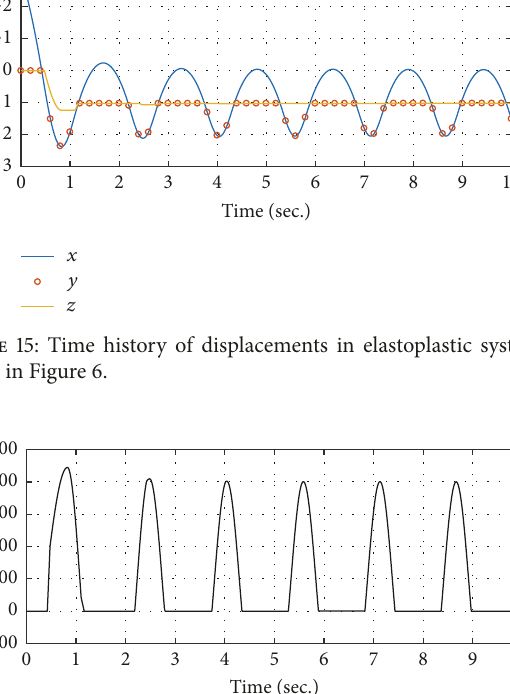
Figure 16: Time history of reaction 𝑅 in elastoplastic system shown in Figure 6.